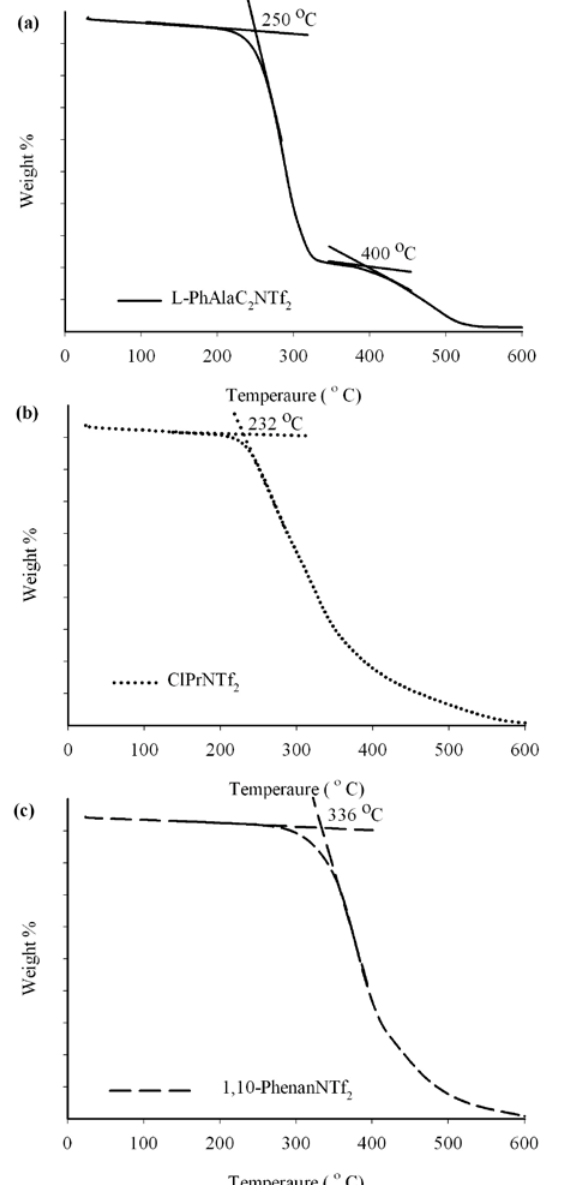
Figure 2. UV-Vis absorption spectra of 10 μM (a) L-PhAlaC NTf , 2 2 , obtained at a 2